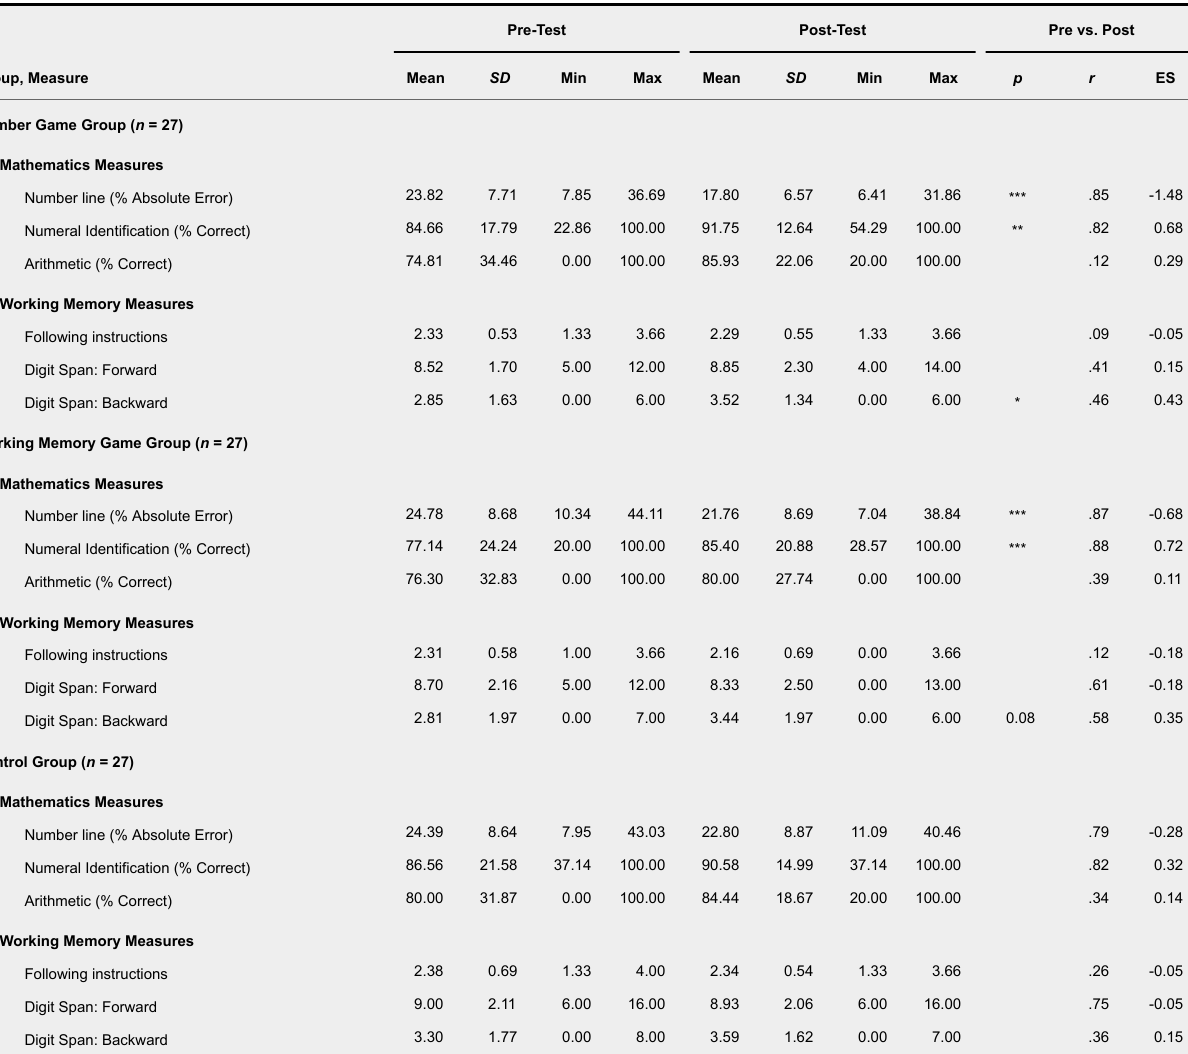
Descriptive Data for the Transfer Measures as a Function of Group